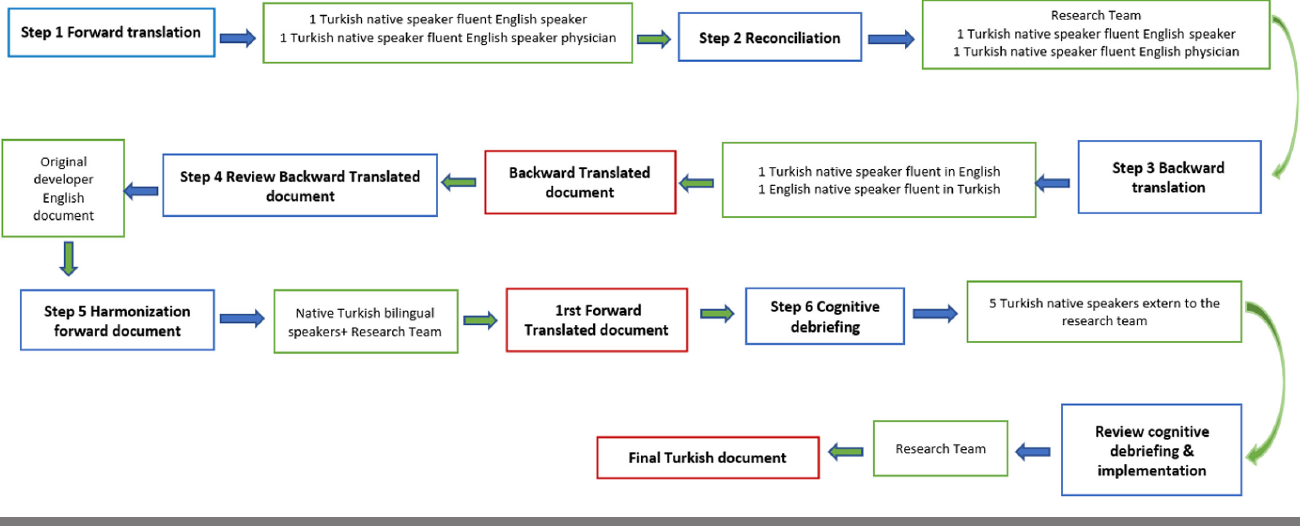
Figure 1. Schematic description of the validation